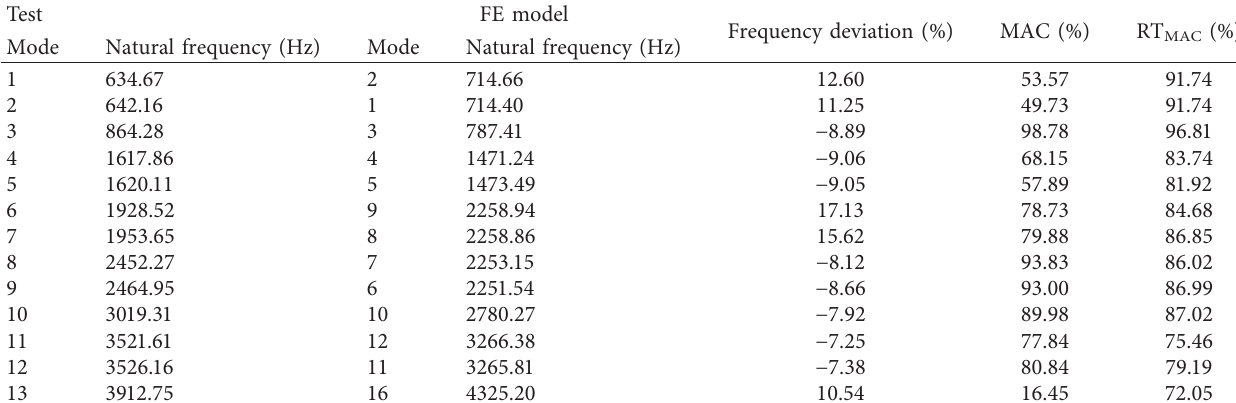
Table 8: Correlation coefficient and frequency deviation between the FE model and test.